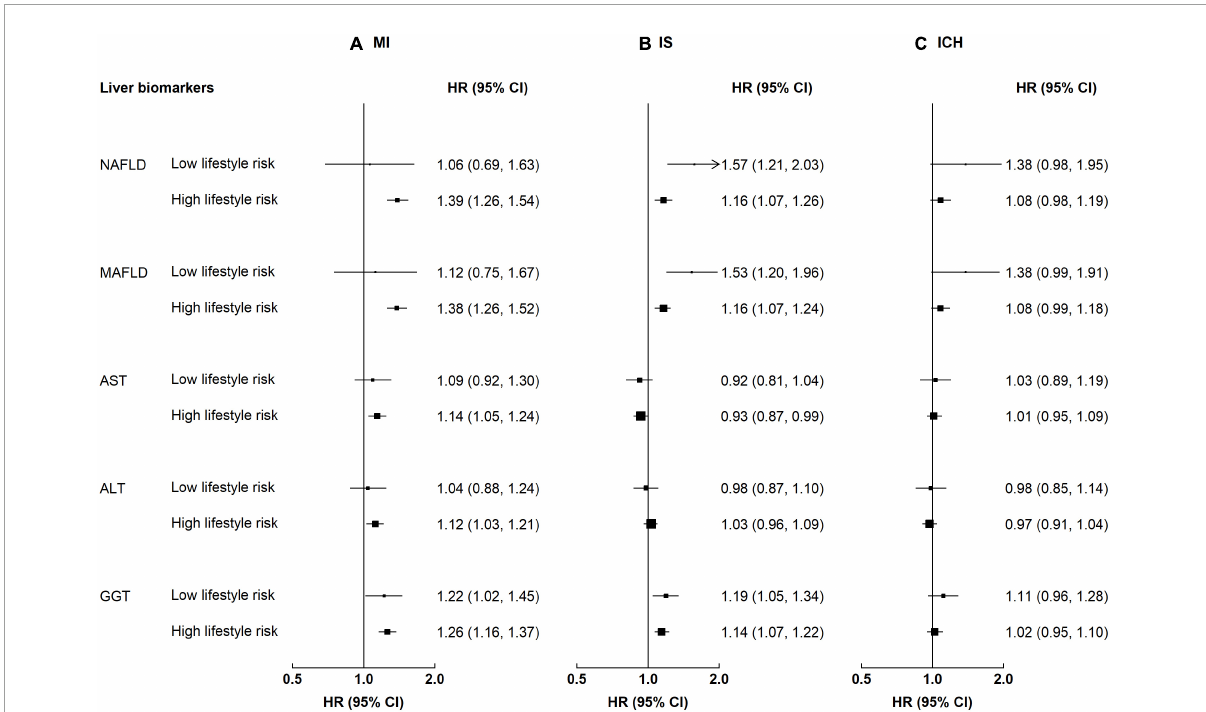
FIGURE4 Associations of liver biomarkers with risk of CVD by lifestyle factors. Columns (A–C) denote the results for MI, IS, and ICH, respectively. Convention as in Figure 3 . Low lifestyle risk denotes 0–1 high-risk lifestyle factors. High lifestyle risk denotes 2–4 high-risk lifestyle factors. p -Values for interaction: MI 0.28–0.82, IS 0.02–0.74, and ICH 0.04–0.61. p -Values for interaction < 0.05: IS, NAFLD 0.03, MAFLD 0.02; ICH, FLI 0.04, MAFLD